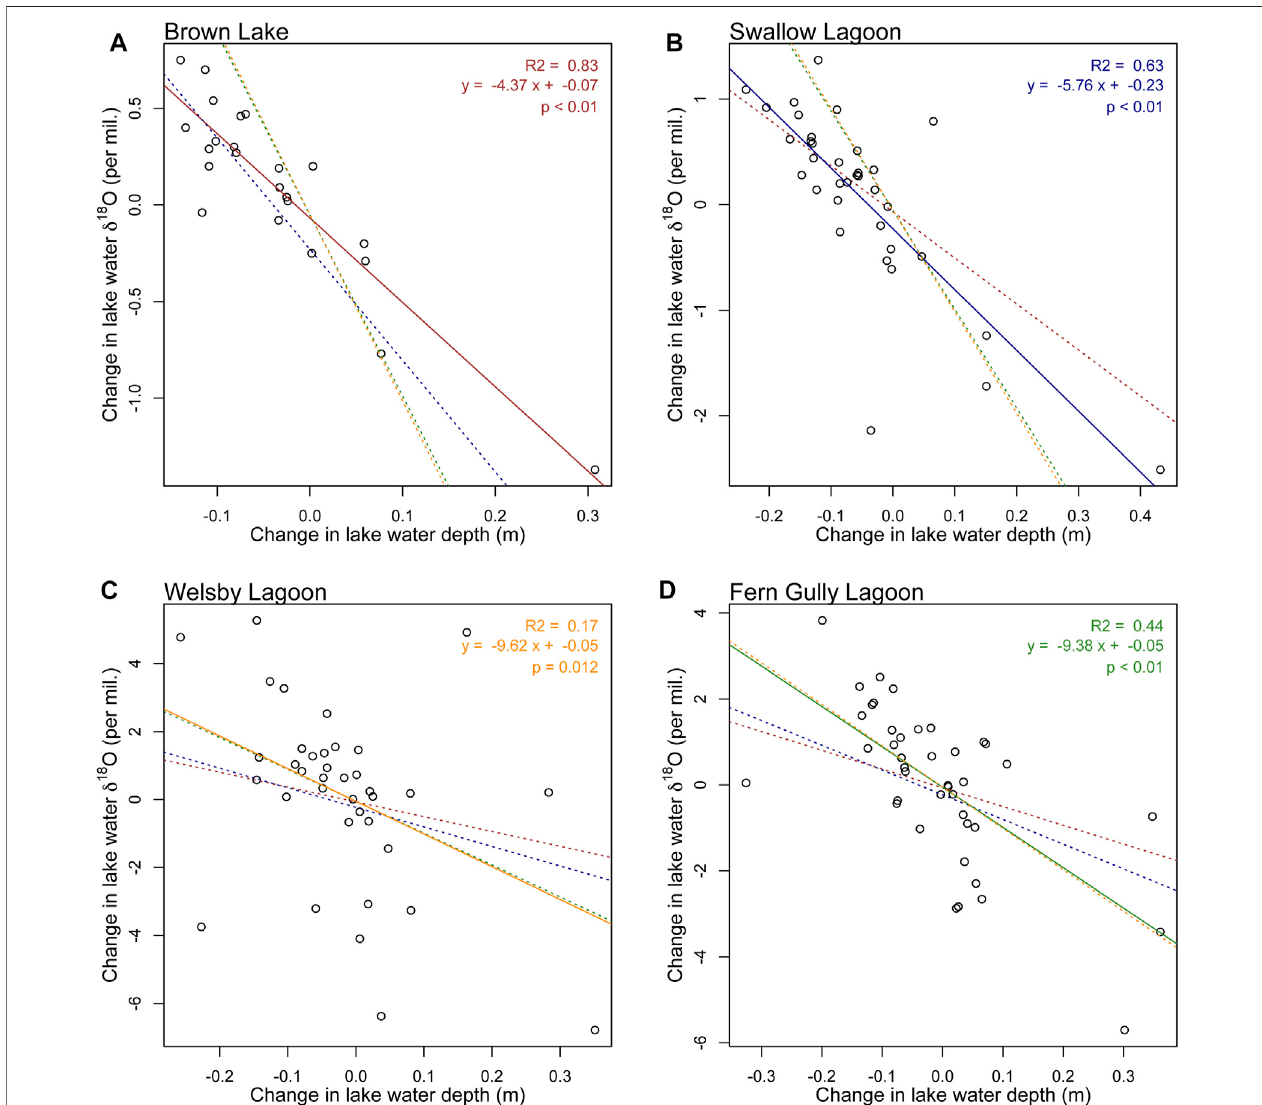
FIGURE6| Sample-by-samplechangein δ 18 Oofwetlandsurfacewaterplottedagainstchangeinsurfacewaterdepthfortheequivalentperiodbetweensampling intervals. Solid lines and associated text refer to the linear regression model for each site. Dotted lines re fl ect linear models derived for the other sites, with line and text colour referring to site [ (A) Brown Lake = brown, (B) Swallow Lagoon = blue, (C) Welsby Lagoon = orange and (D) Fern Gully Lagoon = green].